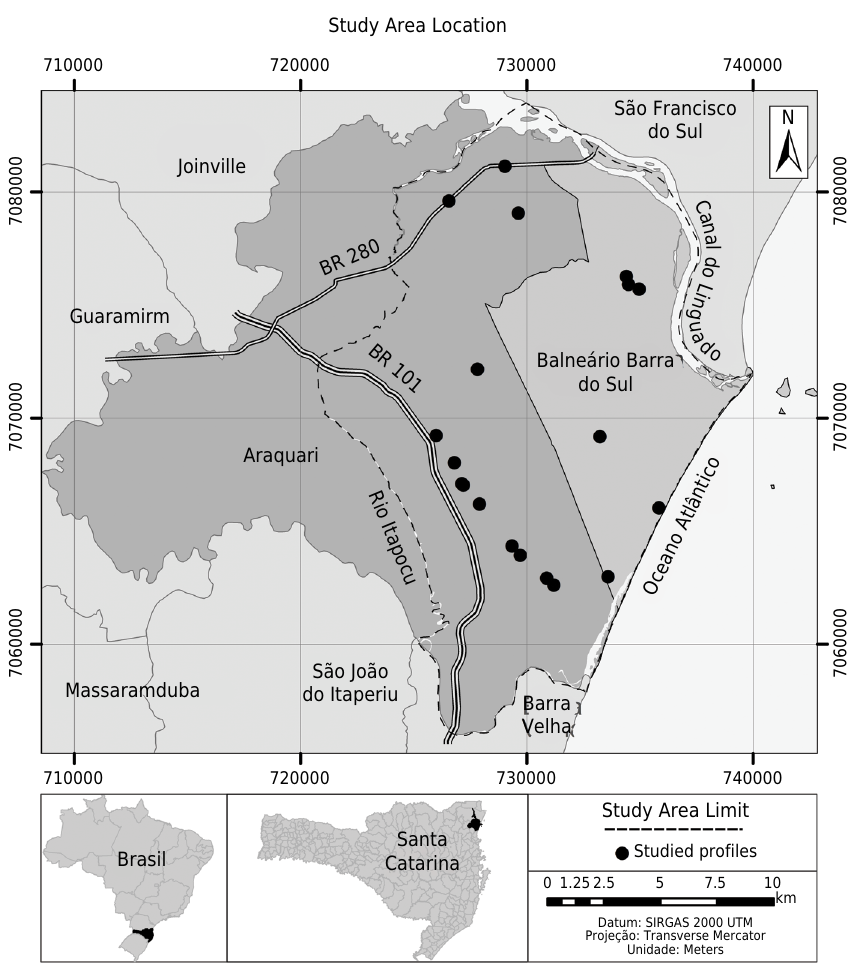
Figure 1. Location of the study area in the northern coast of the state of Santa Catarina,